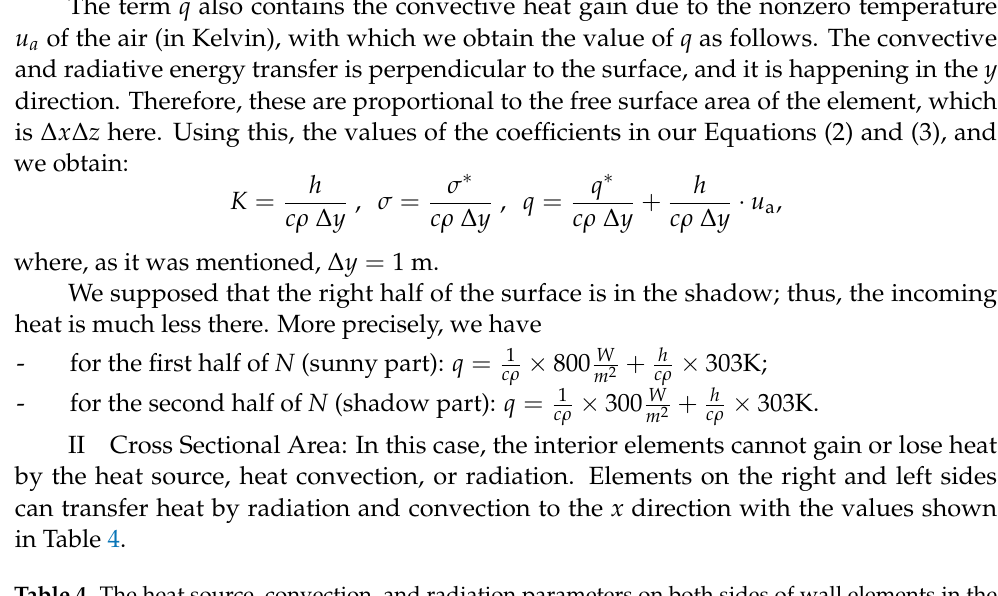
Table 4. The heat source, convection, and radiation parameters on both sides of wall elements in the case of cross-sectional